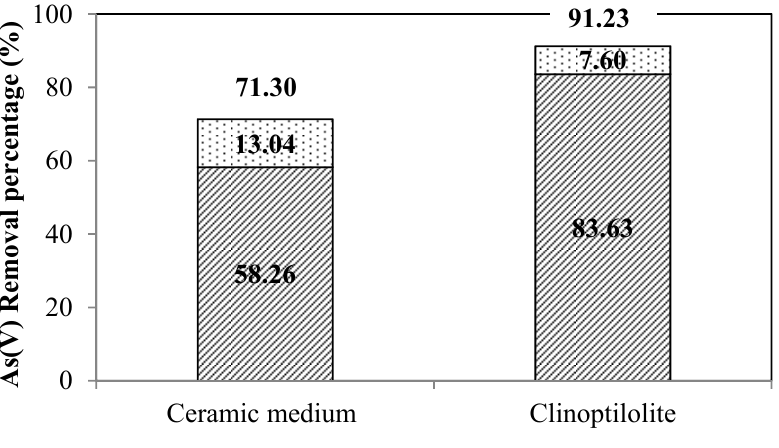
Figure 10. Arsenic (V) removal in full scale NCMG plant with ferric chloride for configurations A and